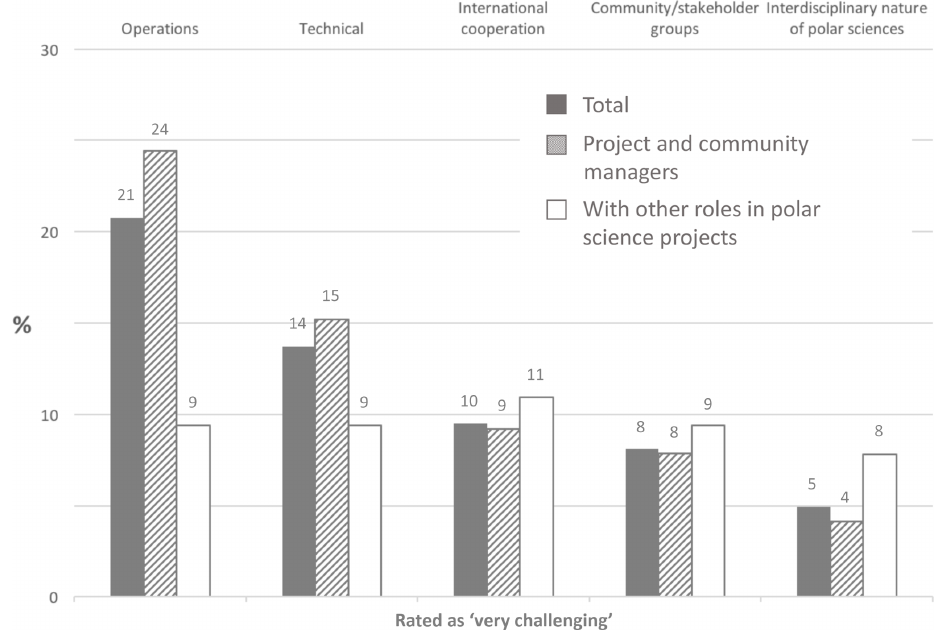
Figure 8. Challenges associated with risk management in polar science projects. Survey respondents (%) rating as “5 – very challenging” when asked the questions Q16: Risk management: Please rate (from 1 to 5) the following challenges.